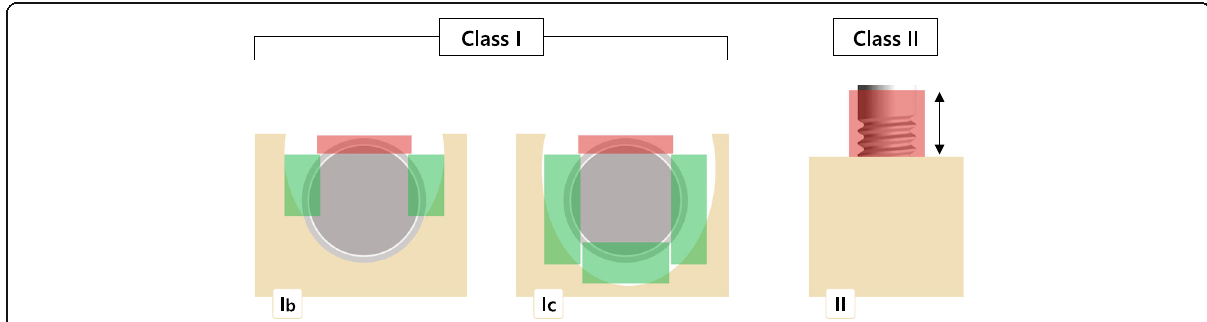
Fig. 1 Combined surgical therapy of peri-implantitis at respective defect sites: class I: intrabony component showing either a buccal dehiscency with a semicircular component (Ib) or a buccal dehiscency with a cicumferential component (Ic). Class II: supracrestal component. The red rectangles indicate the surface areas undergoing an implantoplasty, while the green areas indicate the defect areas undergoing augmentative